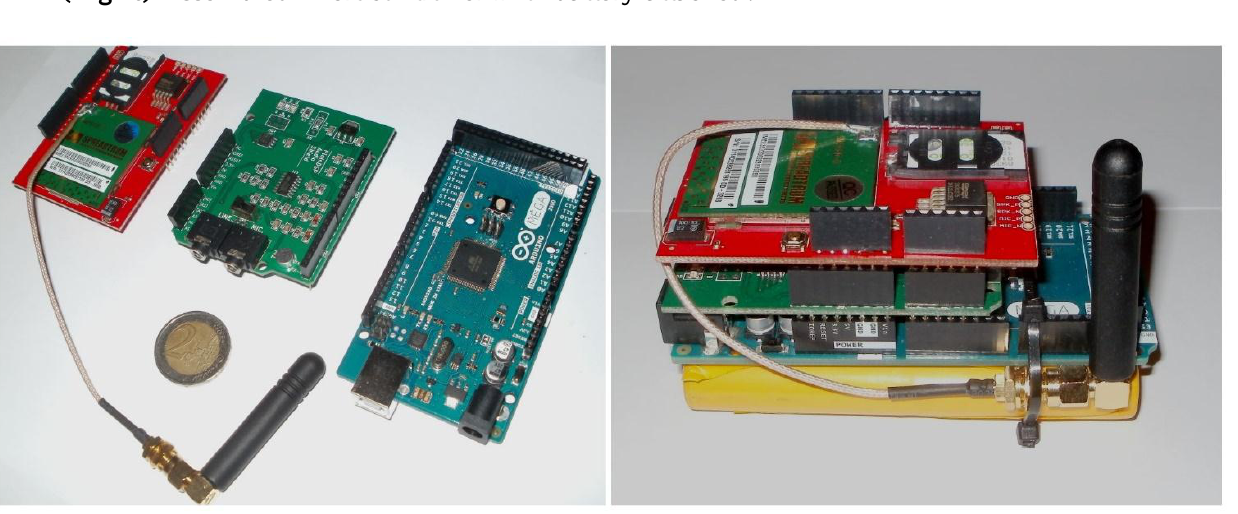
Figure 13. ( Left ) The microcontroller platform and its expansion boards: (from left to right) The GSM expansion board, the audio expansion board and the microcontroller; ( Right ) Assembled microcontroller with battery attached.